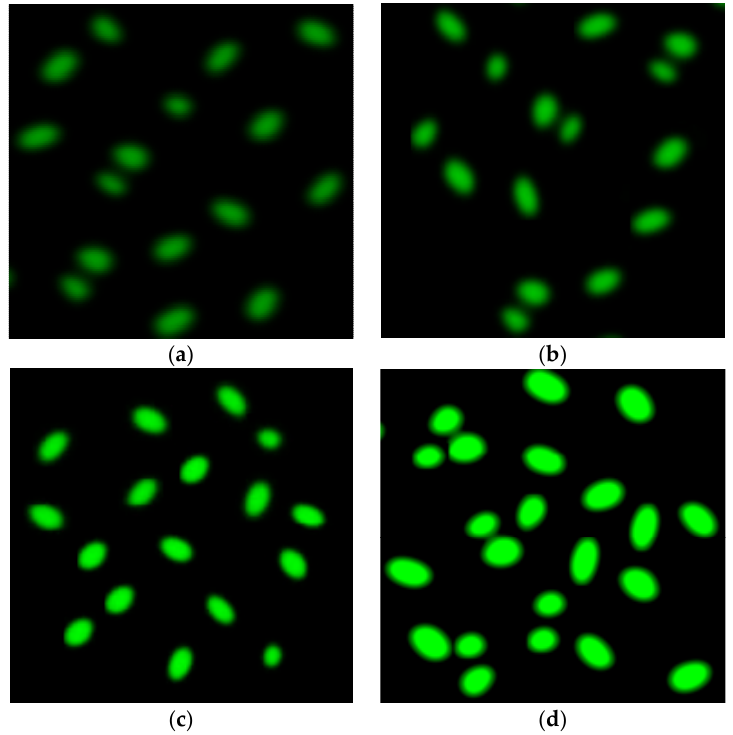
Figure 8. Qualitative characterization of reactive oxygen species (ROS) formation by H2DCFDA staining using fluorescence microscopy ( a ) Control MCF-7 cell line; ( b ) MCF-7 cells treated with GO; ( c ) MCF-7 cells treated with Ag NPs and ( d ) MCF-7 cells treated with GO-Ag nanocomposite.